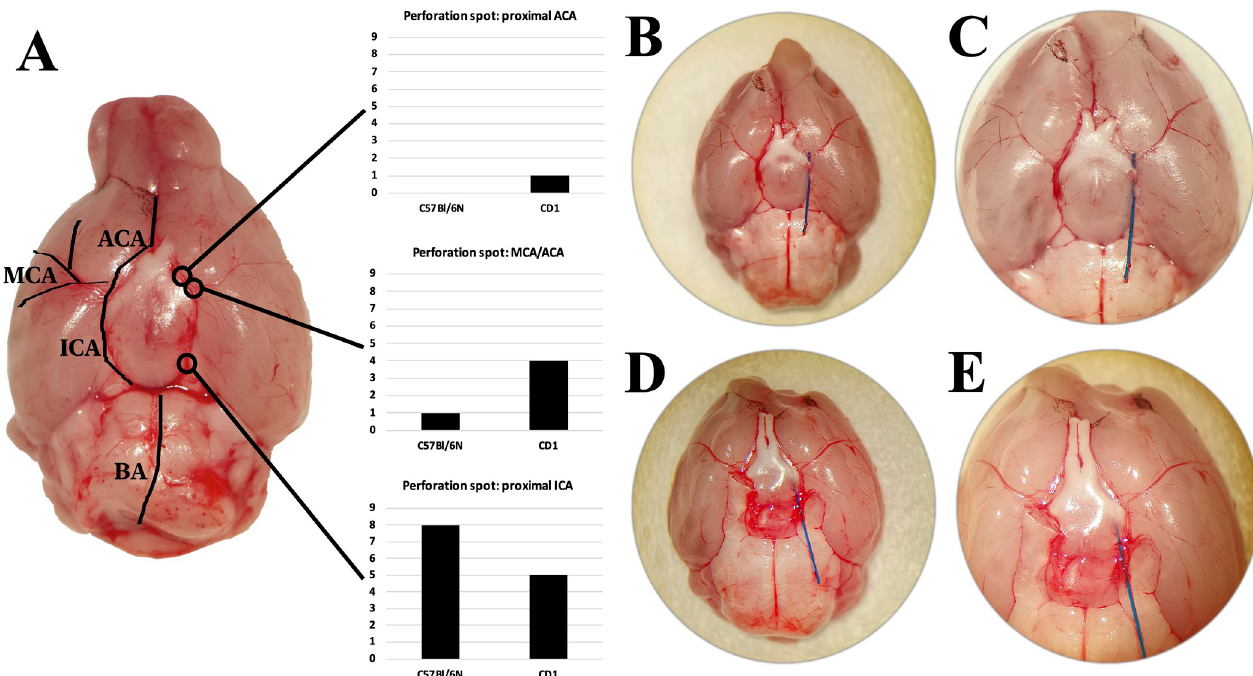
Fig 3. Microscopical evaluation of the perforation spot in CD1- and C57Bl/6-mice ( A ). In C57Bl/6N-mice in most cases the filament perforated the proximal intracranial ICA (n = 8/9; A) (exemplary images; D 25x magnification, E 40x magnification) and seldomly the distal intracranial ICA (n = 1/9). In CD1-mice the proximal intracranial ICA was perforated in 5/10 mice, the distal ICA in 4/10 mice (exemplary images; B 25x magnification, C 40x magnification; it is noteworthy to mention that the filament tip ends in parenchymal tissue) and the proximal ACA in 1/10 mice.